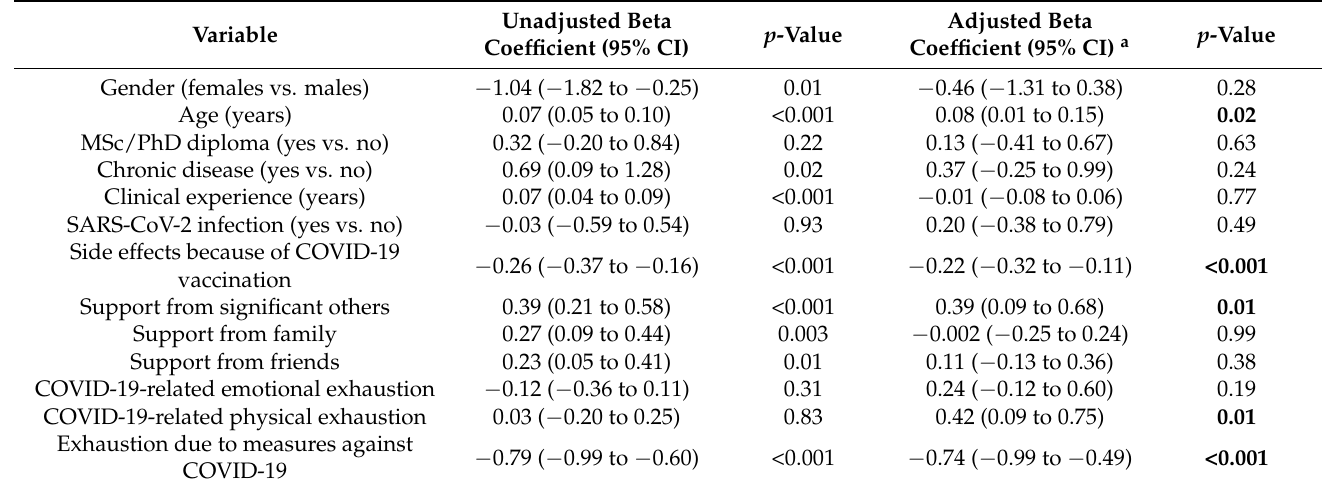
Table 3. Univariate and multivariable linear regression analysis with influenza vaccination intention score as the dependent variable.